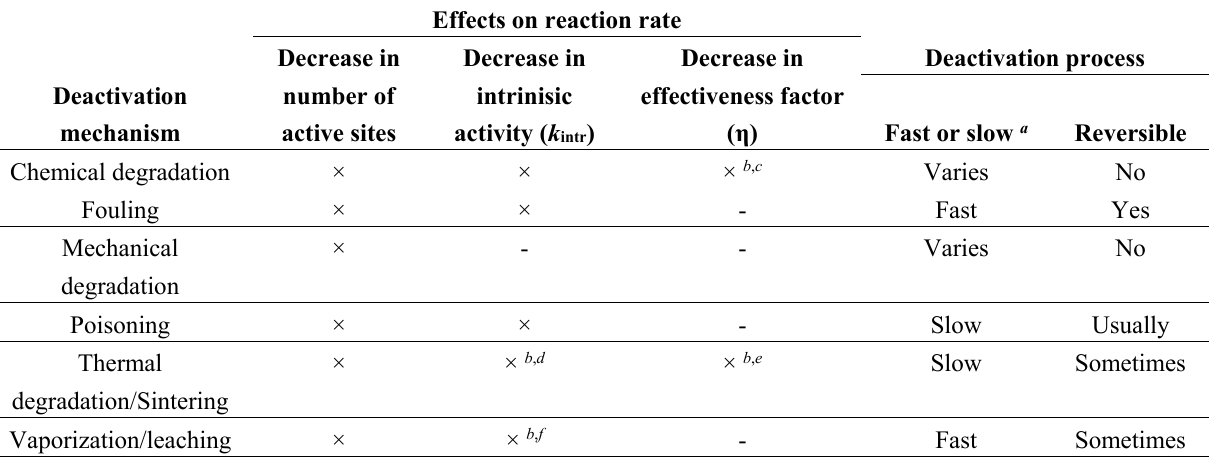
Table 16. How Deactivation Mechanisms Affect the Rate of a Catalyzed Reaction and the Rapidity and Reversibility of Deactivation